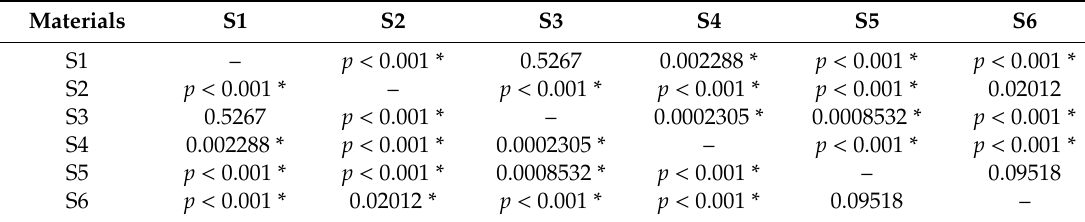
Table 8. Di ff erences in ∆ E after 168 h immersion in currant juice.